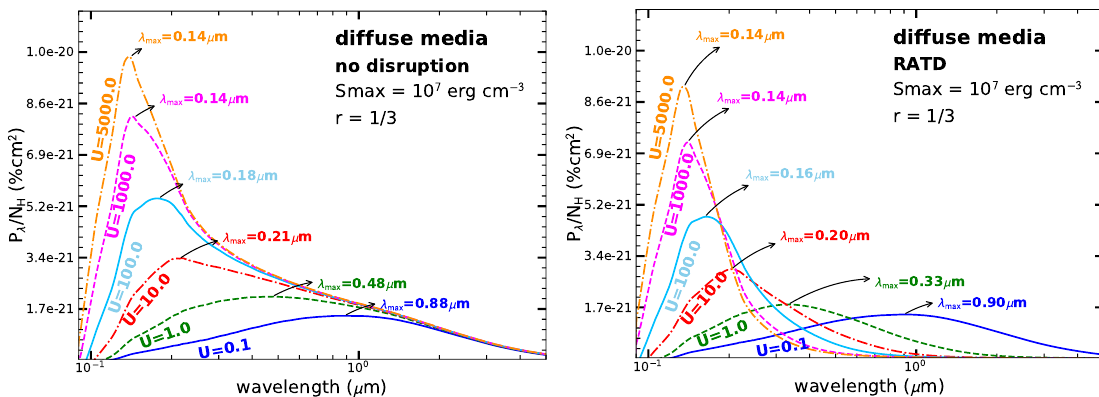
Figure 12. Polarization spectrum due to extinction of starlight by dust grains aligned with axial ratio r = 1/3 by RATs for the diffuse media with various radiation field strengths for two cases without RATD and with RATD. A tensile strength S max = 10 7 ergcm − 3 is considered. From Lee et al.